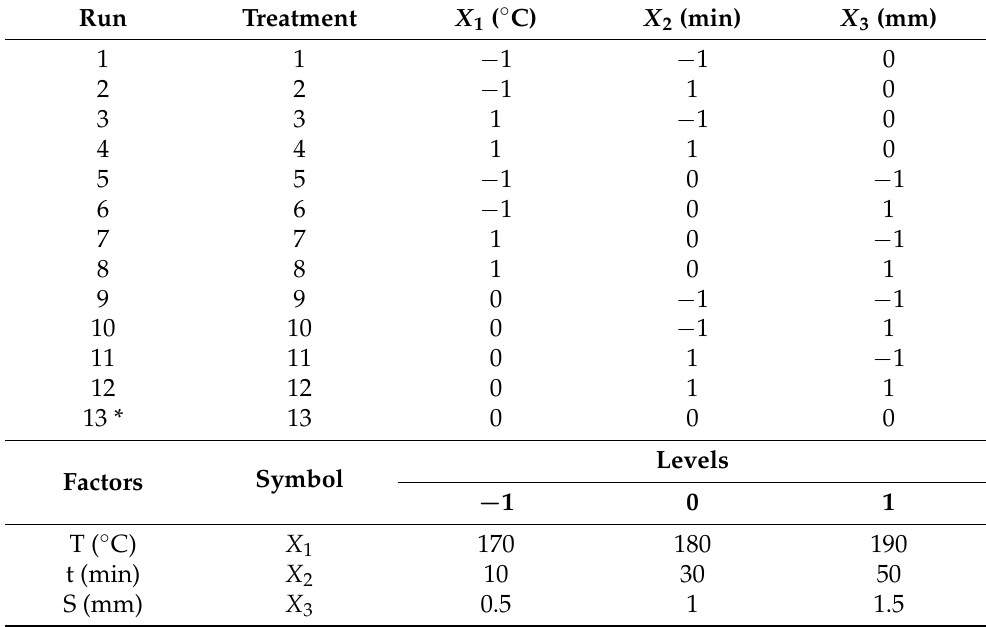
Table 1. Box–Behnken experimental design for the analysis of the SSB pretreatment process.